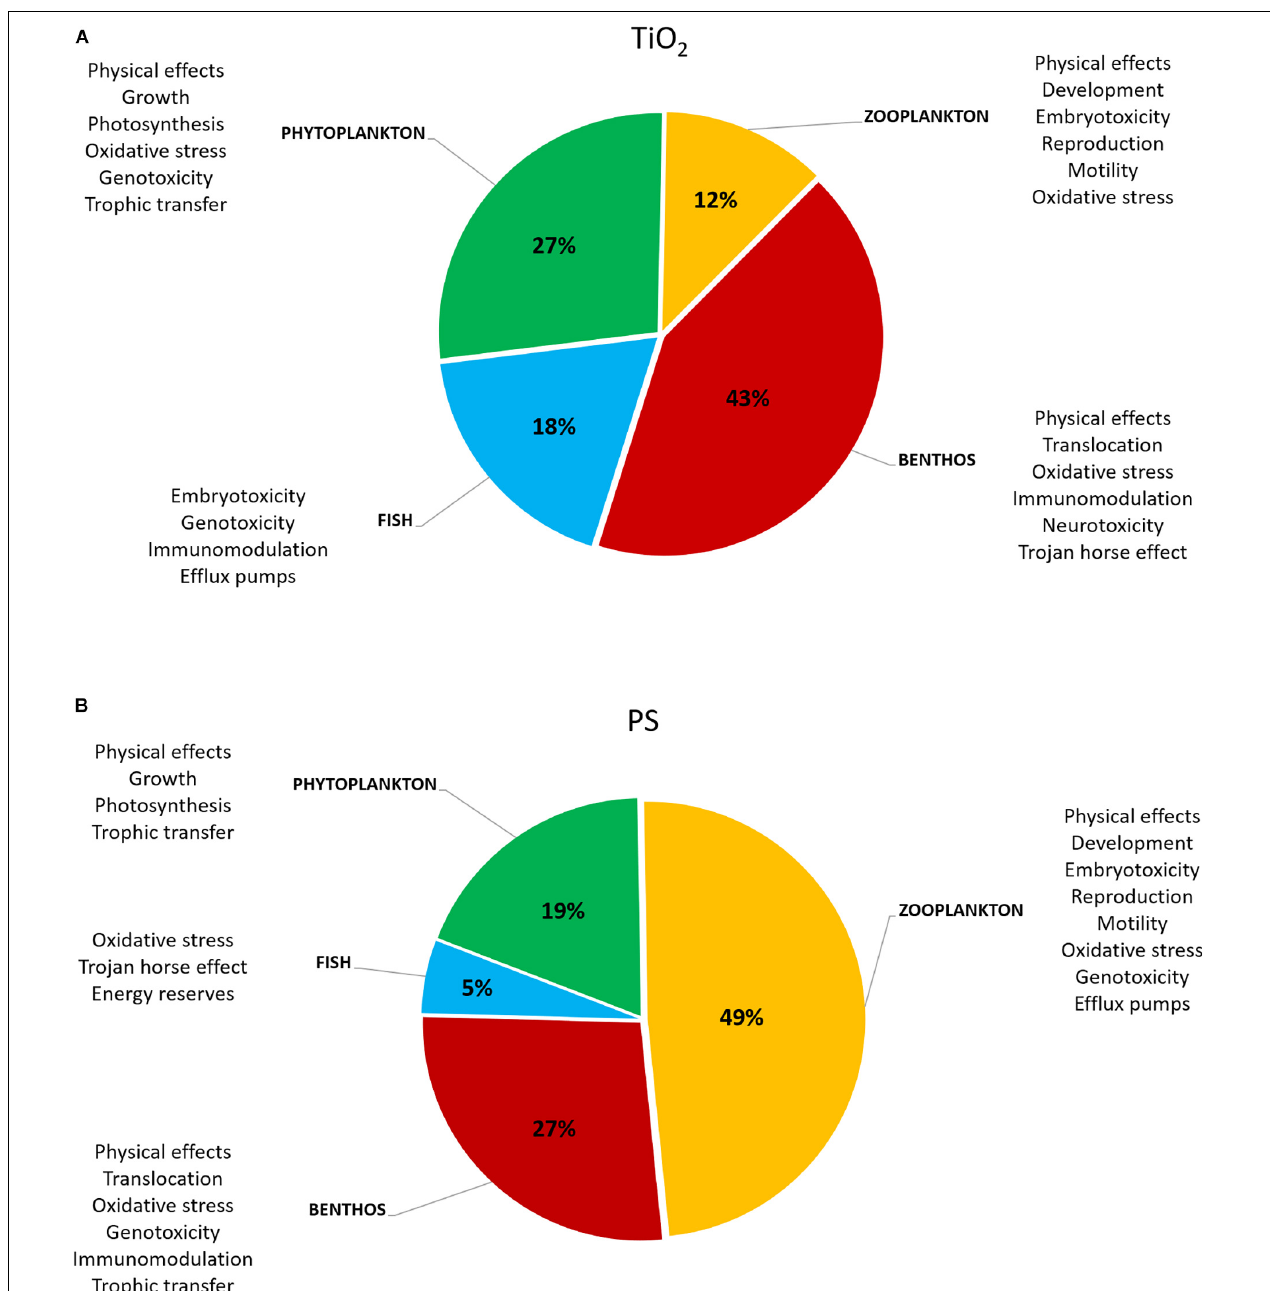
FIGURE 3 | Schematic representation of the distribution of taxa investigated in ecotoxicity studies [ (A) TiO 2 and (B) polystyrene (PS) NPs] and related documented effects. Please refer to Supplementary Material section for details on literature used. Total number of studies was 37 for PS and 38 for TiO 2 .